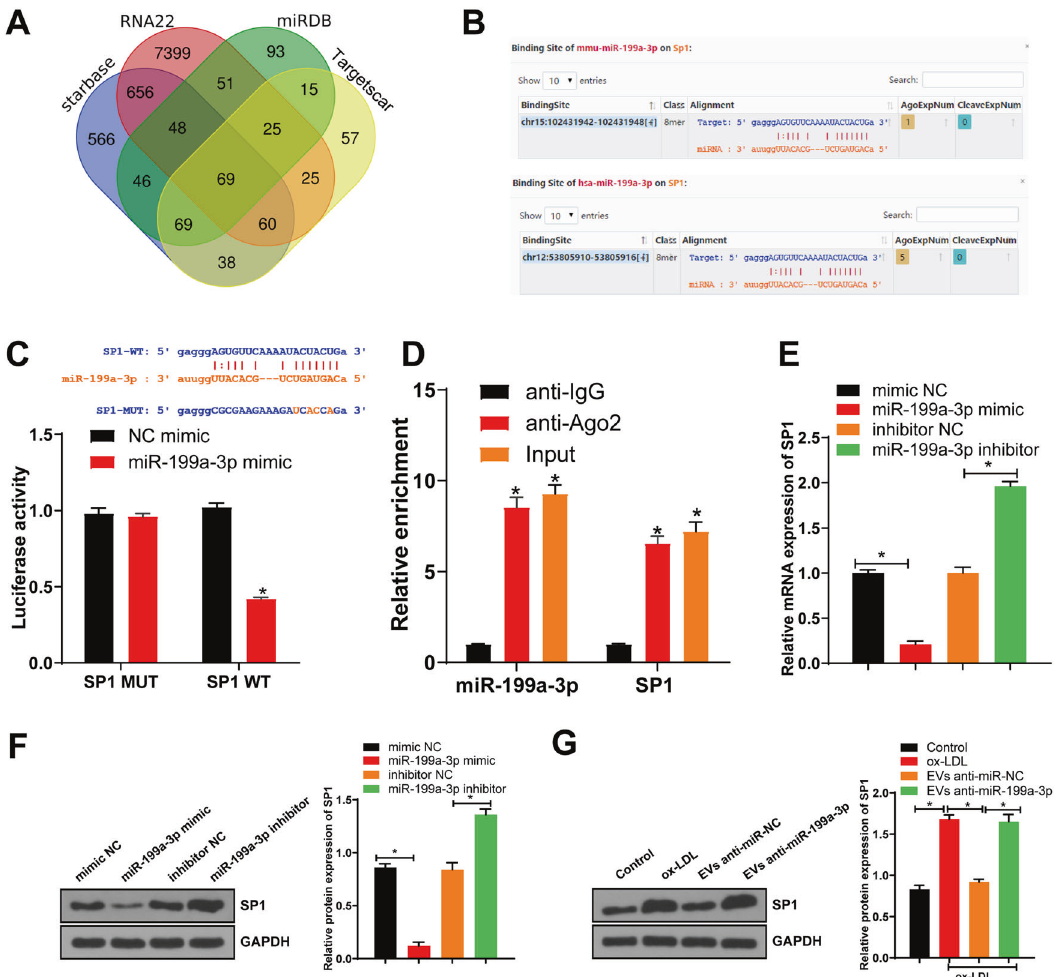
Fig. 4 miR-199a-3p targeted SP1. A The target genes of miR-199a-3p were predicted through TargetScan and Starbase databases. B The binding site between miR-199a-3p and SP1 was predicted through the Starbase database. C The binding relationship between miR-199a-3p and SP1 was veri fi ed using dual-luciferase assay. D RNA immunoprecipitation of Ago2 antibody by MAEC lysate. E miR-199a-3p expression in each group was detected using qRT-PCR. F SP1 expression in each group was detected using western blot. G SP1 expression in MAECs after EPC-EVs treatment was detected using western blot. Each experiment was repeated three times independently. Measurement data are depicted as mean ± SD. The t test was used for the comparisons between two groups. One-way ANOVA was employed for the comparisons among multiple groups, followed by Tukey ’ s multiple comparisons test. * p <